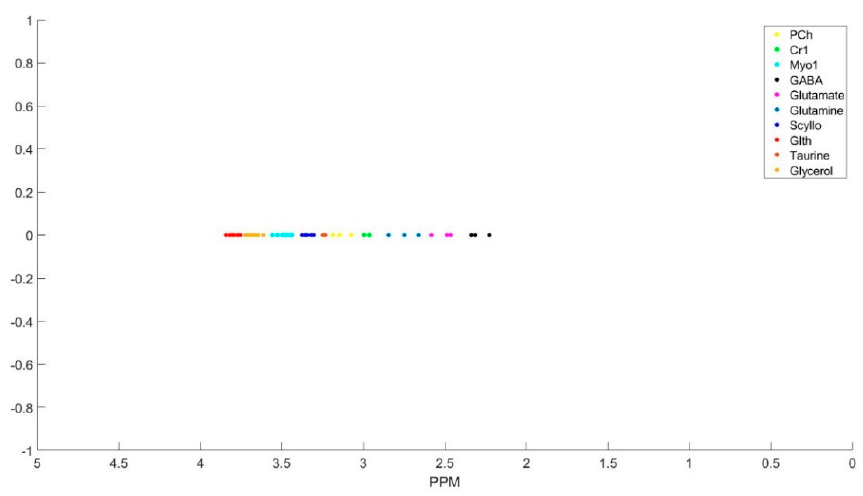
Figure A4. Metabolites listed as group 2 and their corresponding peaks. Figure 9. Metabolites listed as group 2 and their corresponding peaks. Figure 9. Metabolites listed as group 2 and their corresponding peaks.